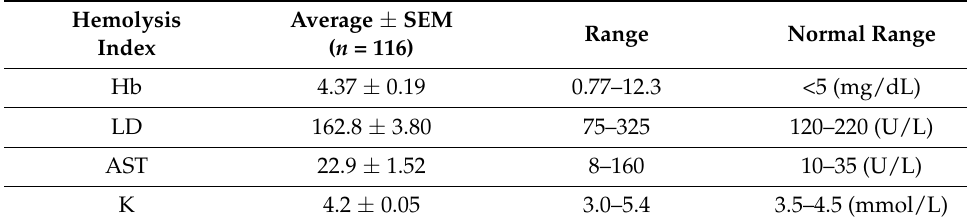
Table 1. Measurement of hemolysis indexes in 116 leftover serum samples.